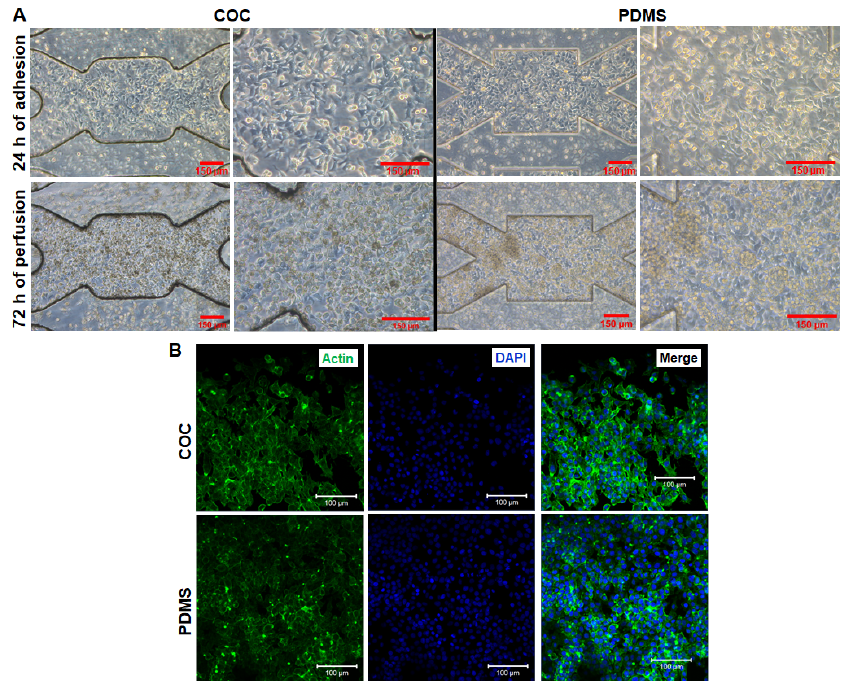
Figure 6. Characterization of dynamic cultures in biochip: ( A ) cell morphology after adhesion and at the end of 72 h of perfusion (scale bar 150 µm), ( B ) Phalloidin and DAPI stainings of cells at the end of perfusion: DAPI (nuclei, blue) and phalloidin (F-actin, green); scale bar 100 µm. To evaluate the functionality of HepG2/C3a cells cultured in COC biochips, albumin production was monitored throughout the 72 h of perfusion and compared with the results obtained in PDMS biochips. The results are shown in Figure 7B. the albumin production of cells cultured in COC bioreactors was of 135 ± 27, 123 ± 32 and 87 ± 25 ng/h/10 6 cells after 24, 48 and 72 h of perfusion, respectively. The quantity of albumin produced by HepG2/C3a cells in PDMS biochips was similar: 149 ± 41 (24 h), 113 ± 39 (48 h) and 90 ± 5 (72 h) ng/h/10 6 cells.